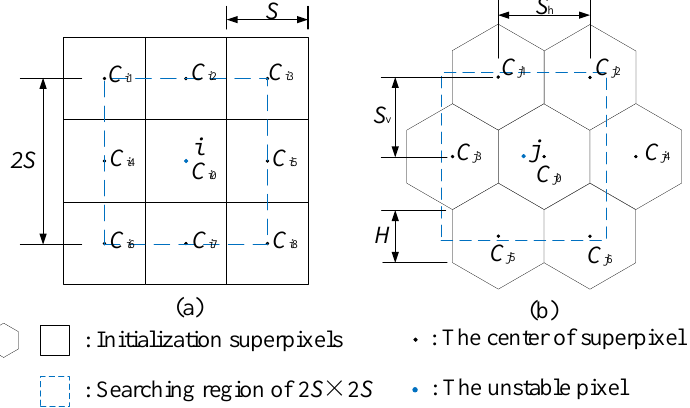
Figure 7. Distribution of cluster centers. ( a ) Square distribution. ( b ) Hexagonal